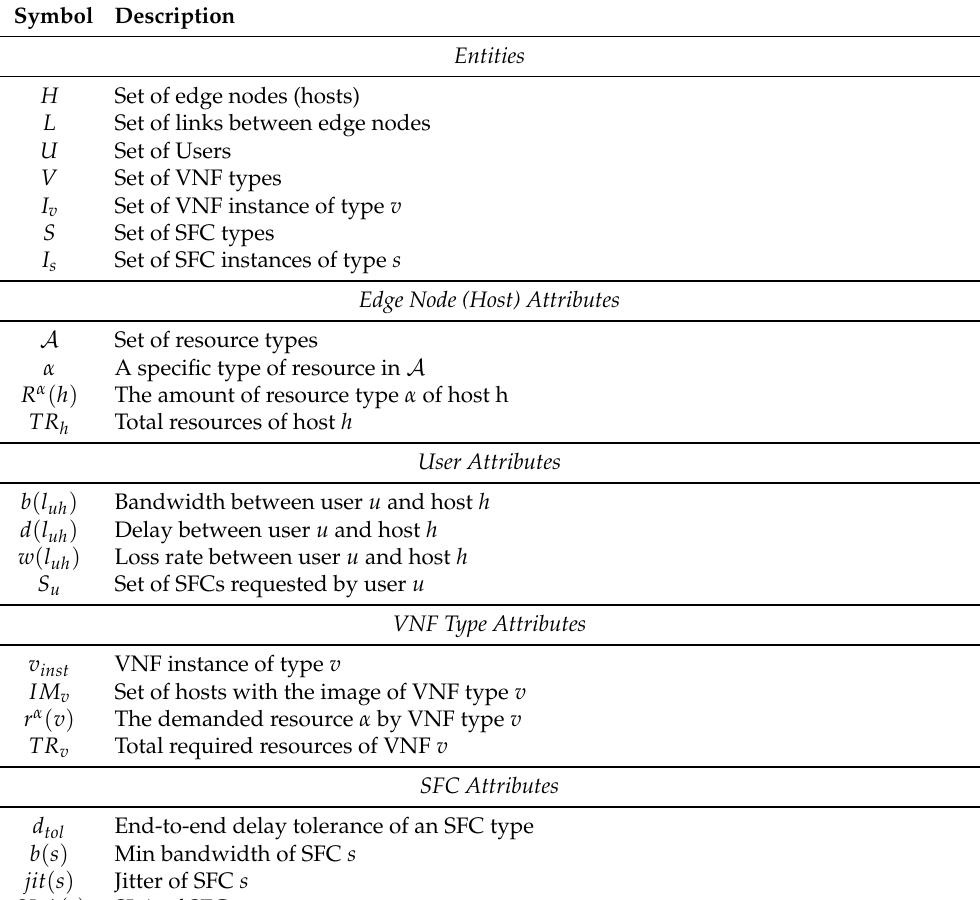
Table 2. Entities and attributes